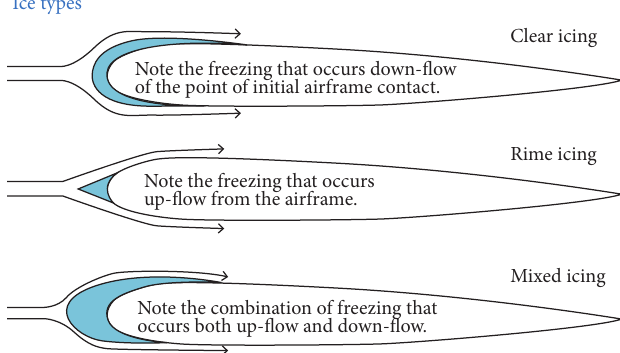
Figure 13. The ice shapes that accumulated on aircraft surfaces (Stothers 2013; Kind et al. 1998).